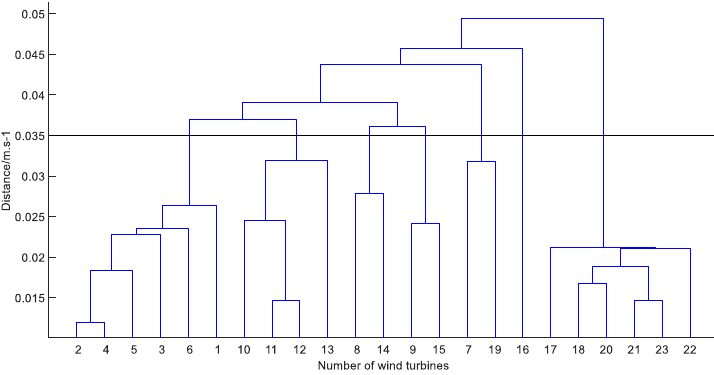
Figure 1. Chart of distance coefficient pedigree.